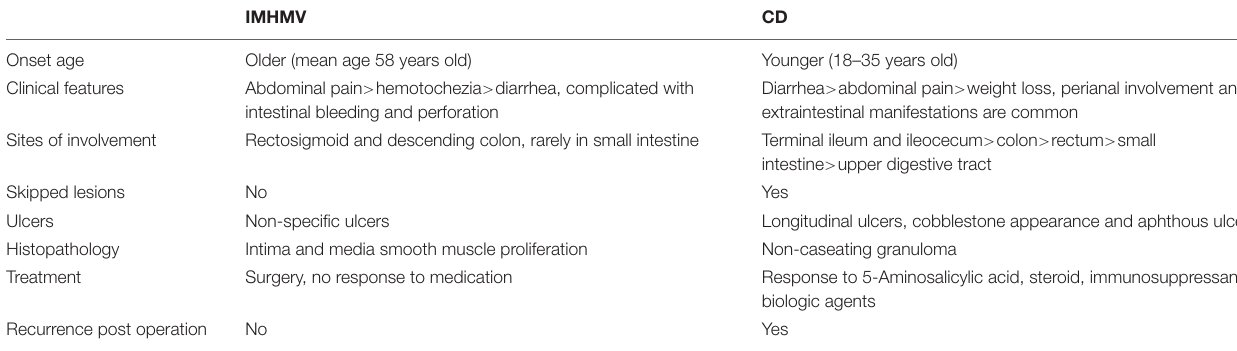
TABLE 2 | Comparison between IMHMV and CD.